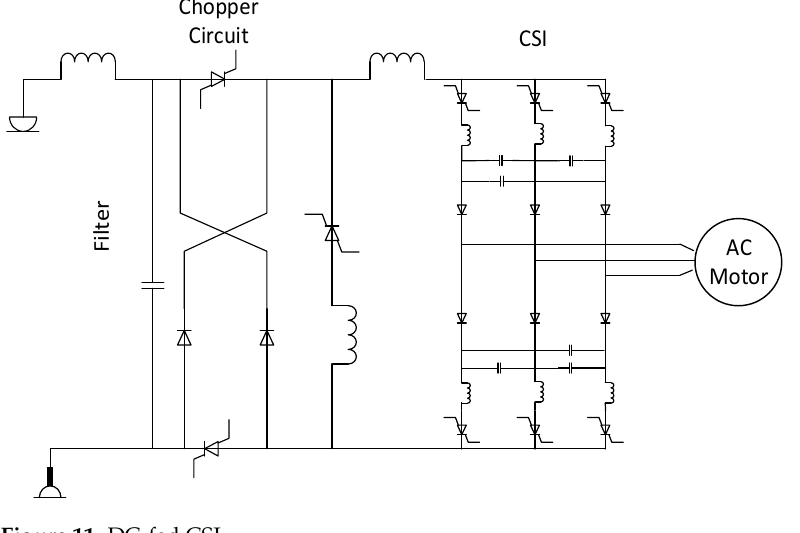
Figure 11. DC-fed CSI.